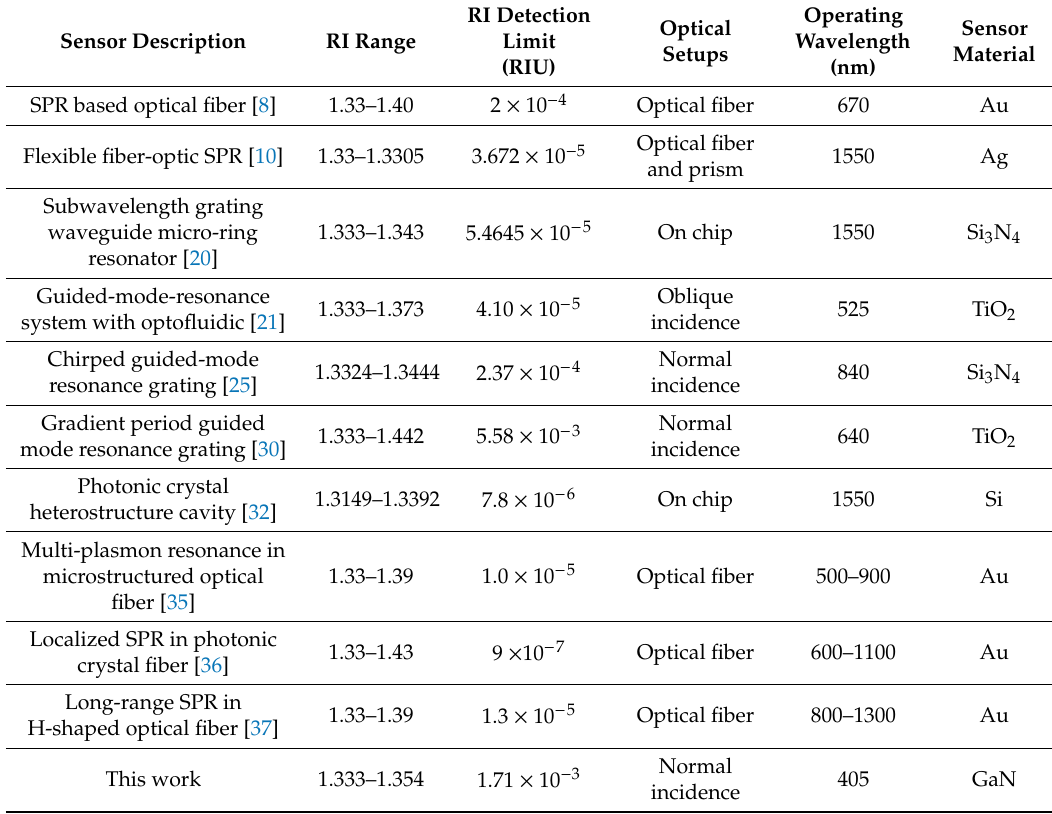
Table 1. Comparison of several RI sensor